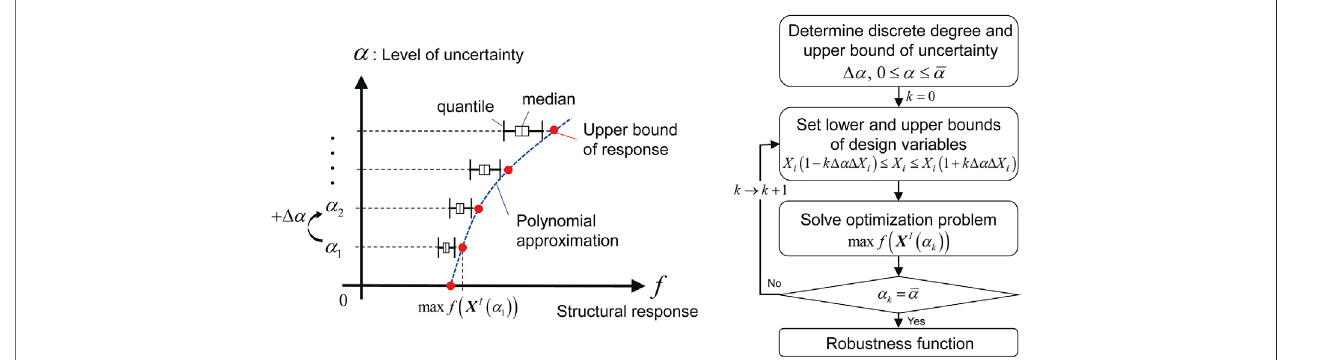
FIGURE 2 | Schematic diagram and fl owchart for evaluation of robustness function.